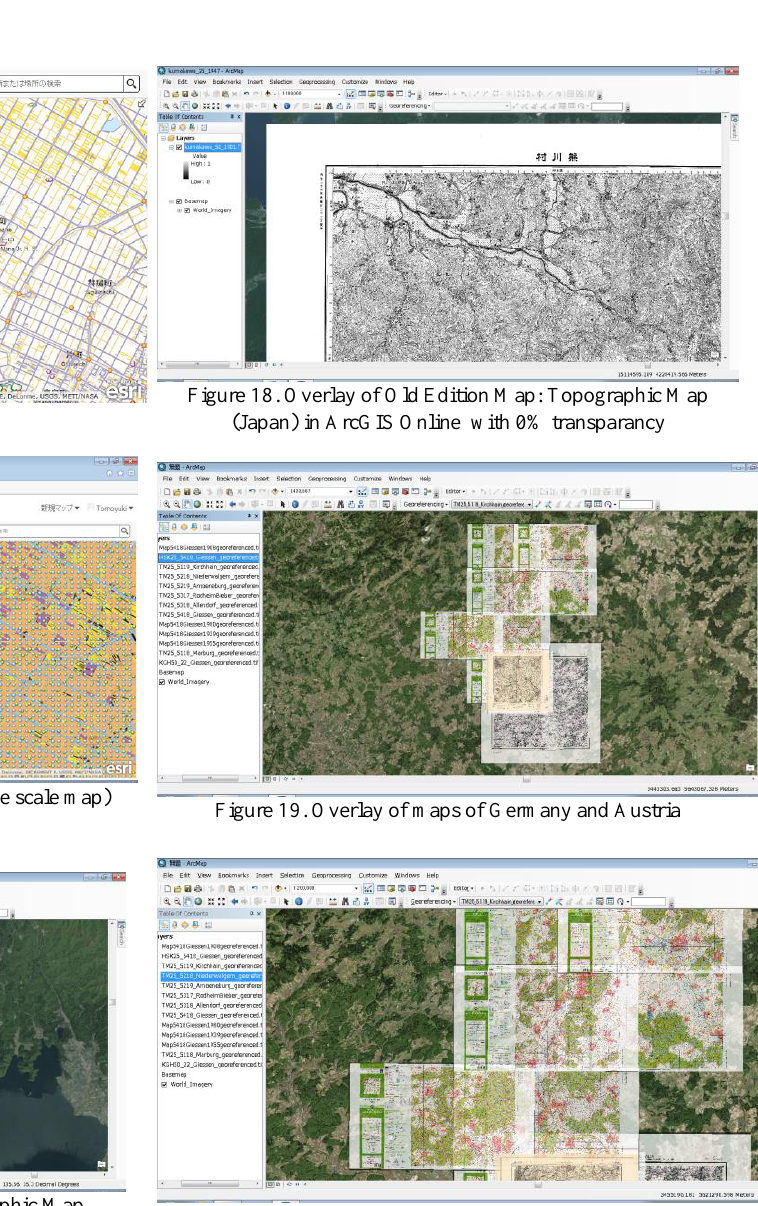
Figure 20. Zoomed-in Overlay of maps of Germany and Austria